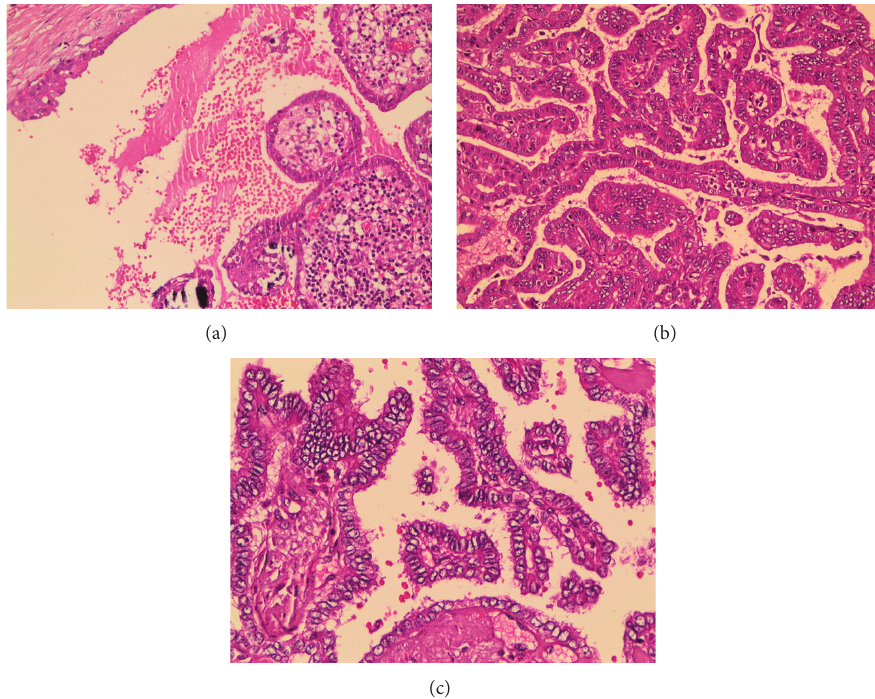
Figure 3: (a) The tumor is within a cystic structure which is lined by stratified squamous epithelium ( × 200, H&E). (b) Papillary structures which are typically complex branching, covered by epithelium with disturbed polarity and eosinophilic cytoplasm ( × 200, H&E). (c) Nuclei are large, oval shaped and show clearing and some have grooves ( × 400,